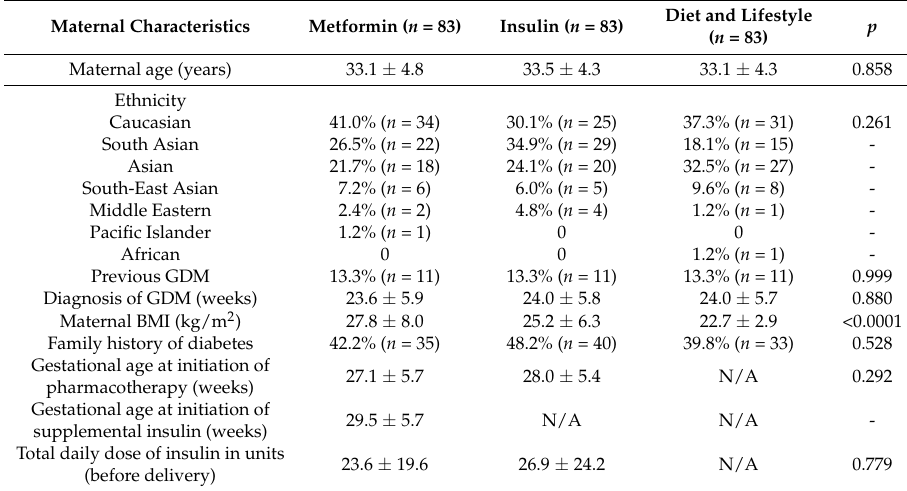
Table 1. Demographics and characteristics of women with gestational diabetes mellitus (GDM) managed with metformin, insulin or diet and lifestyle modification.